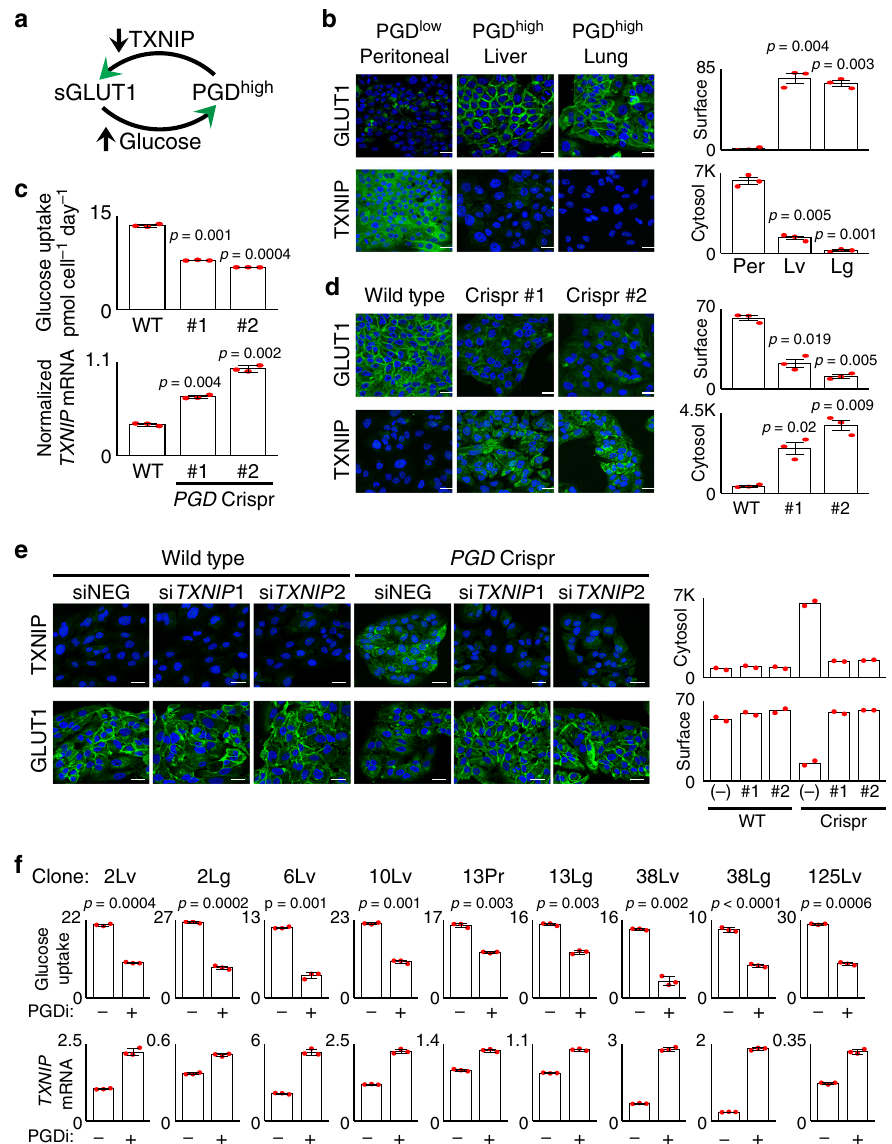
Fig. 2 TXNIP suppression is PGD-dependent. a Illustration depicting how PGD-driven suppression of TXNIP can allow retention of surface GLUT1 with increased glucose uptake. b Confocal IF detected high surface GLUT1 signals (top, cobblestone pattern) and reduced cytosolic TXNIP signals (bottom) in PGD high liver and lung metastases compared with a control PGD low peritoneal deposit from the same patient. c PGD Crispr/Cas 5 (#1, #2) reduced glucose consumption rates (top) and increased TXNIP expression (bottom qRT-PCR) relative to wild-type (WT) baseline controls ( n = 3 technical replicates per sample, error bars: s.d.m., indicated p values calculated by two-tailed t tests). d Confocal IF detected reductions in surface GLUT1 (top) with increased cytosolic TXNIP (bottom) in response to PGD Crispr/Cas (#1, #2), compared to wild-type baseline controls (WT). e Similar confocal IF experiments